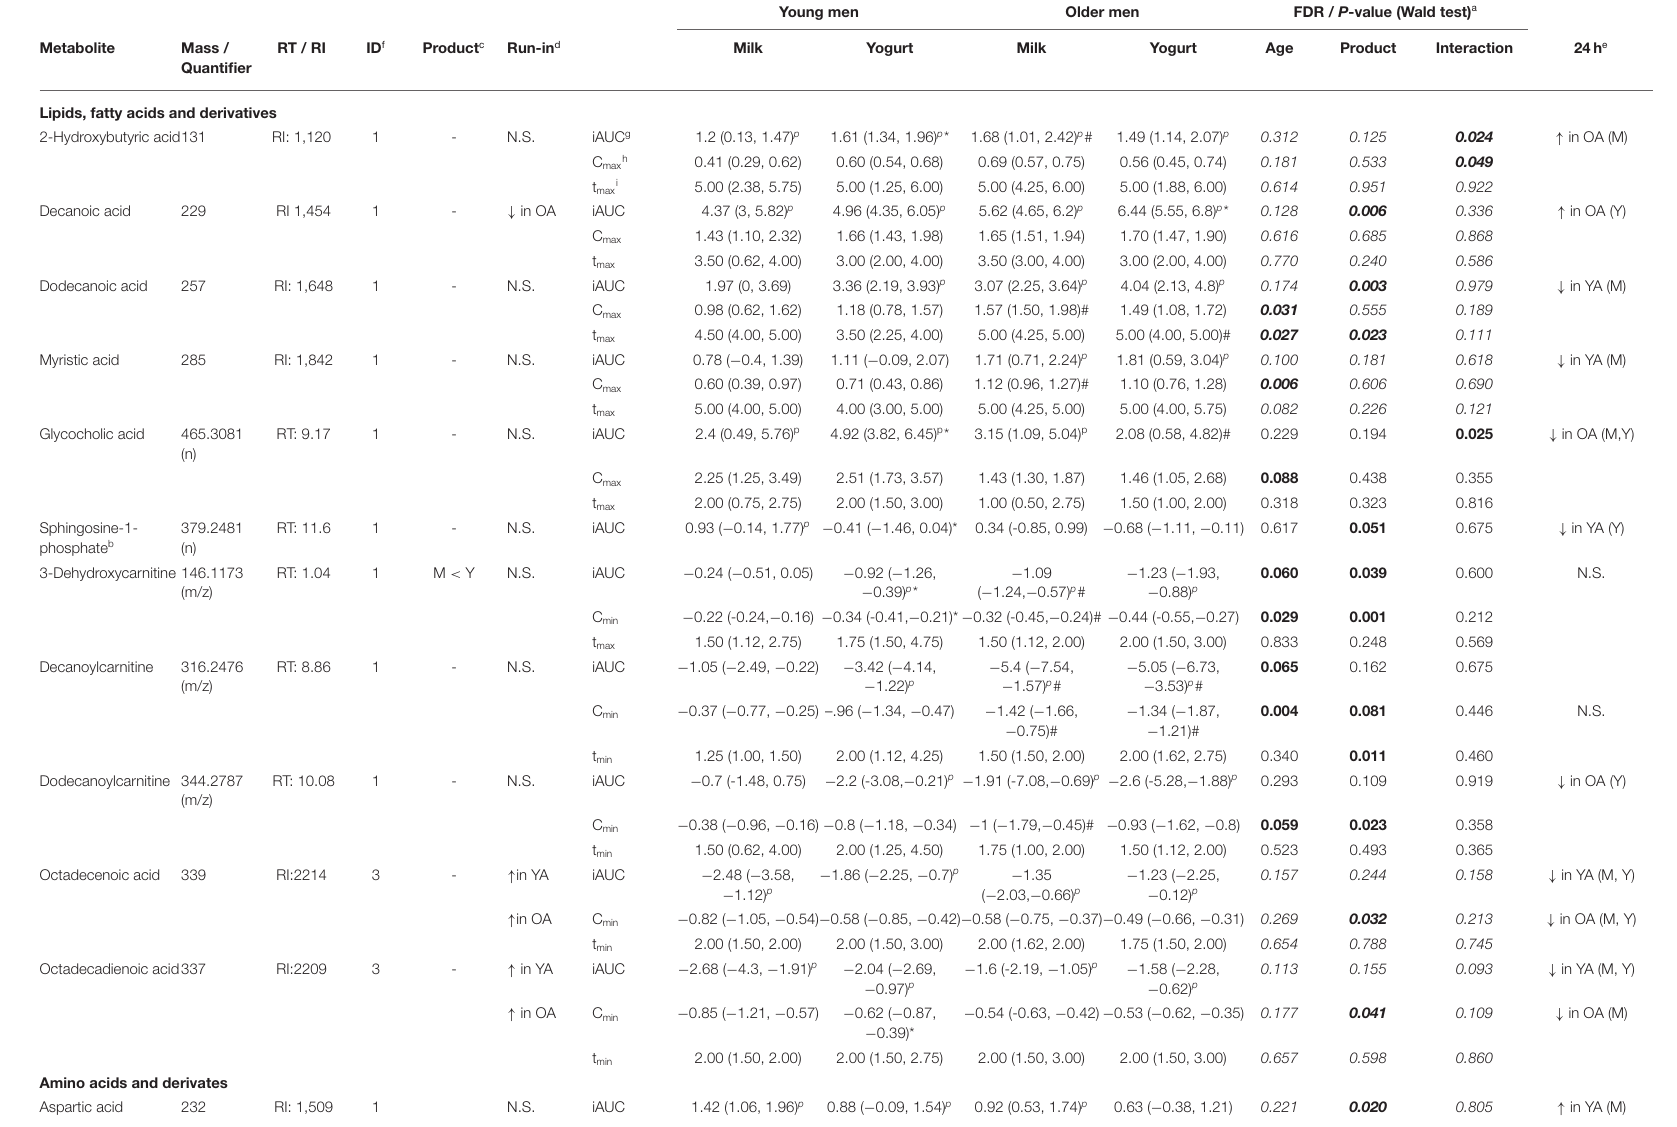
TABLE 1 | List of identified discriminant blood metabolites derived from LC-MS and GC-MS analyses with significant differences in their iAUC, C max (C min ), or t max (t min ) [median (IQR)] either by age, product, or their interaction after the intake of milk or yogurt in young and older